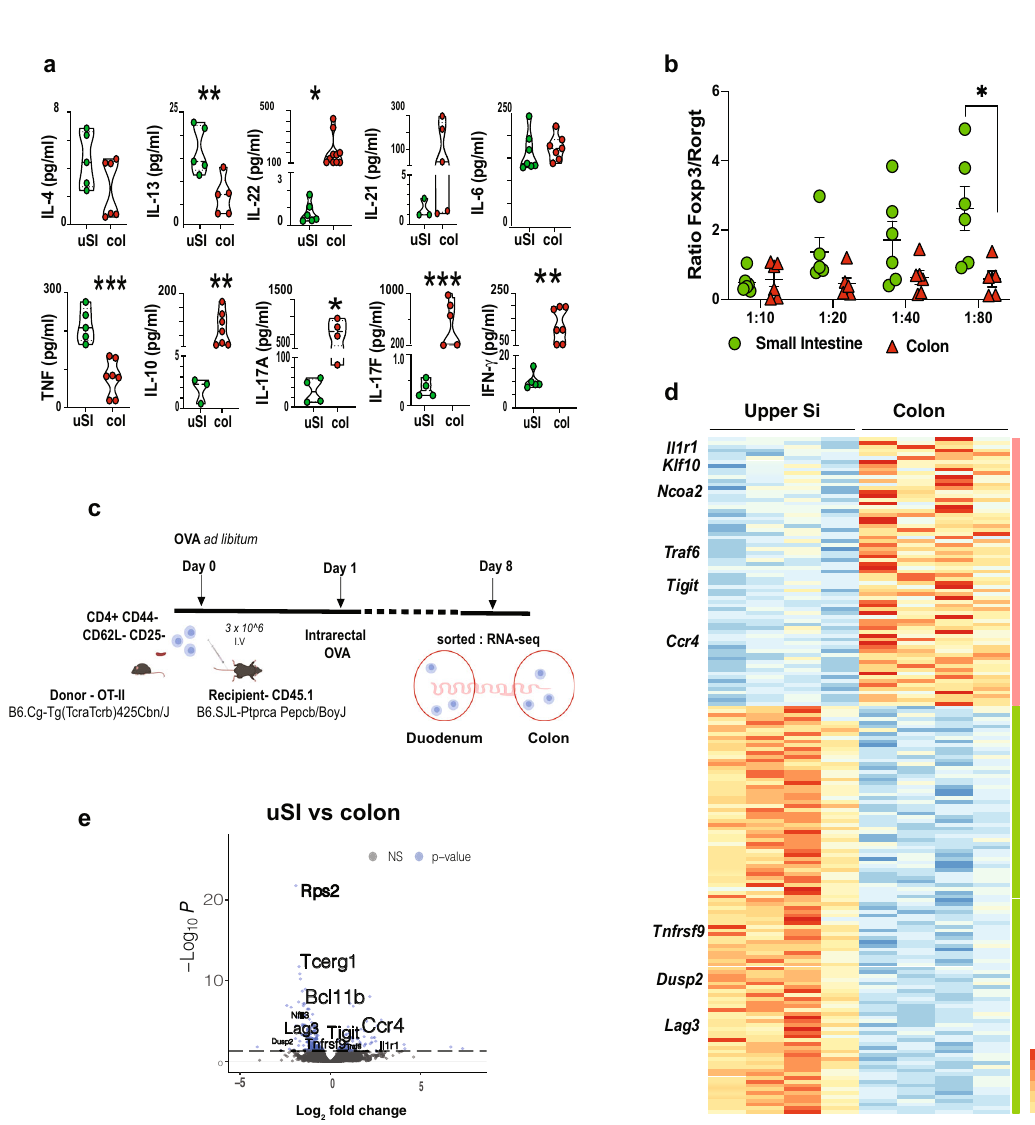
Fig. 3 Gut regional DC induce distinct T-cell differentiation. a Cytokine quanti fi cation by Legendplex from supernatants of upper small intestine (uSI) (duodenum and proximal jejunum) LP sorted DCs cultured with naive OT-II CD4 + T for 7 days in the presence of OVA peptide 323 – 339 . Unpaired two-tailed Student ’ s t test. Boxes and bars represent mean ± SEM. * p = 0.04 (IL-22) * p = 0.02 (IL-17A), ** p = 0.009 (IL-13), ** p = 0.01 (IL-10), ** p = 0.004 (IFN- γ ), *** p = 0.0002 (TNF) *** p = 0.001 (IL-17F). b Foxp3 and ROR γ t ratios in different DC:T-cell ratios. Two-way ANOVA followed by Tukey post hoc test for multiple comparisons.* p = 0.017. N = 5; a pool of three mice/region of the gut over at least two independent experiments. c Adoptive transfer scheme. CD45.1 mice received 3 × 10 6 naive T cell (CD4 + CD62L + CD44 − CD25 − ) from OT-II mice. Mice were then given OVA (8 g/L) in the drinking water for 7 days and received an intra-colonic injection of OVA (2.4 mg/mice) 24 h after T-cell transfer. LP cells from the uSI and colon were then collected, and OT- II cells were sorted and sequenced by Smart – Seq2. d Heatmap and highlighted genes from OT-II cells sorted as described in c . e Volcano plot showing upregulated and downregulated genes in OT-II cells from c . Source data are provided as a Source Data fi le upper small intestine (uSI) and colon (col). Biorender was used for illustration on